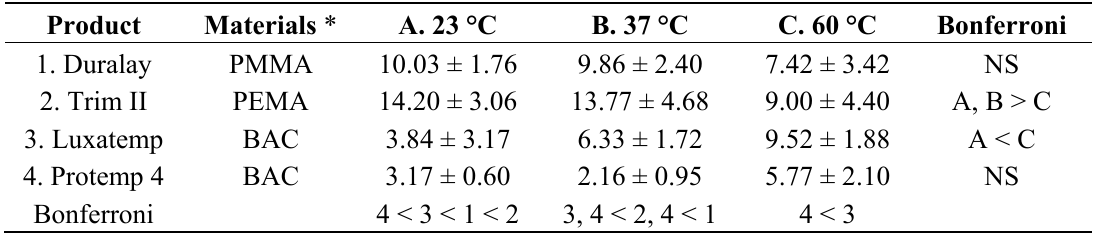
Table 4. Mean color differences ( Δ E*) (±SD) of the materials and curing